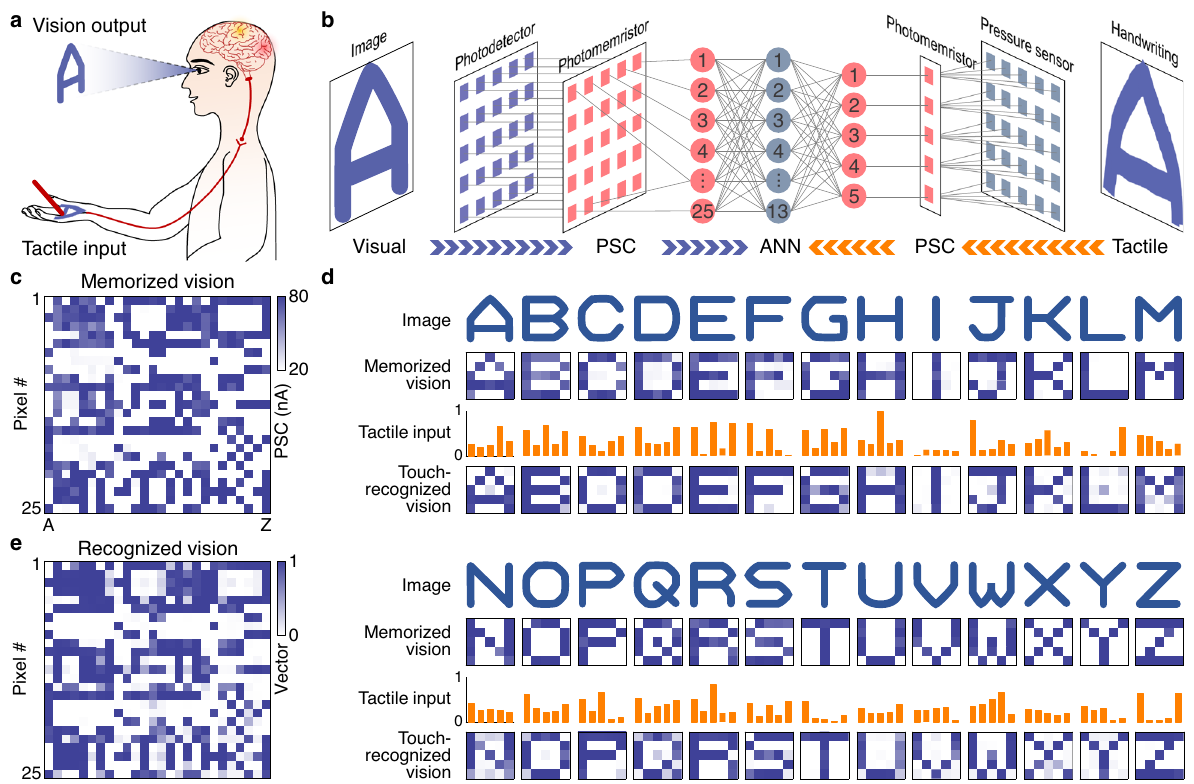
Fig. 4 Tactile-visual crossmodal recognition. a Illustration of the human ability to recognize and visualize tactile input. b Schematic of the arti fi cial tactile- visual system. Tactile inputs from an array of 5 × 5 pressure sensors are dimensionally reduced to fi ve data streams (one photomemristor per fi ve sensors). The visual data stream consists of 25 channels. The ANN consists of fi ve input, thirteen hidden, and 25 output neurons. c Vision memory (photomemristors PSC states) recorded after projecting optical images of the alphabet letters A – Z onto an array of 5 × 5 photodetectors for 2 s. The vision memory supervises training of the ANN with tactile inputs. d Images, vision memory, and handwritten tactile inputs of alphabet letters A – Z. The fourth and eight rows show the images of alphabet letters that are recognized and reproduced by handwritten inputs after ten training epochs. e Summary of reproduced vision vectors. The data correspond closely to the vision memory shown in ( c ), demonstrating tactile-visual sensory integration and crossmodal